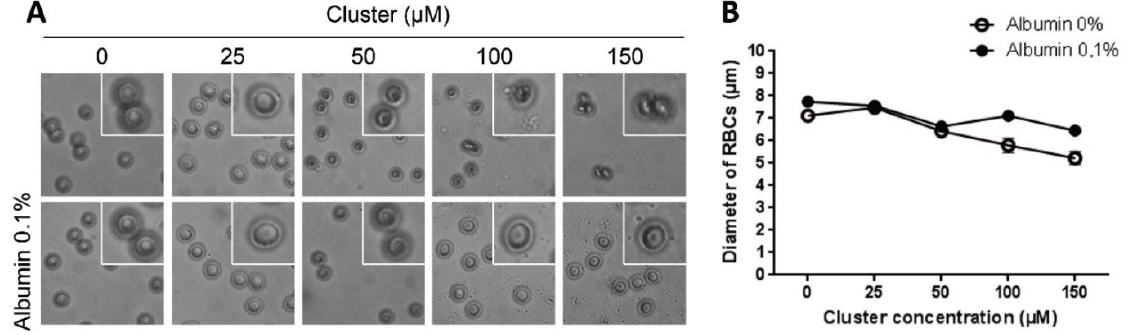
Figure 2. Morphology of human erythrocytes after acute exposition to different concentrations of the cluster with or without albumin. ( A ) Representative pictures of the experimental conditions are shown. Exposition to 100 and 150 µM of the cluster without albumin leads to crenation of erythrocytes, compared to controls; and ( B ) The size of erythrocytes is significantly reduced at high doses of the cluster ( p < 0.05). Both morphological alterations and reduction in size were prevented under co-incubation with